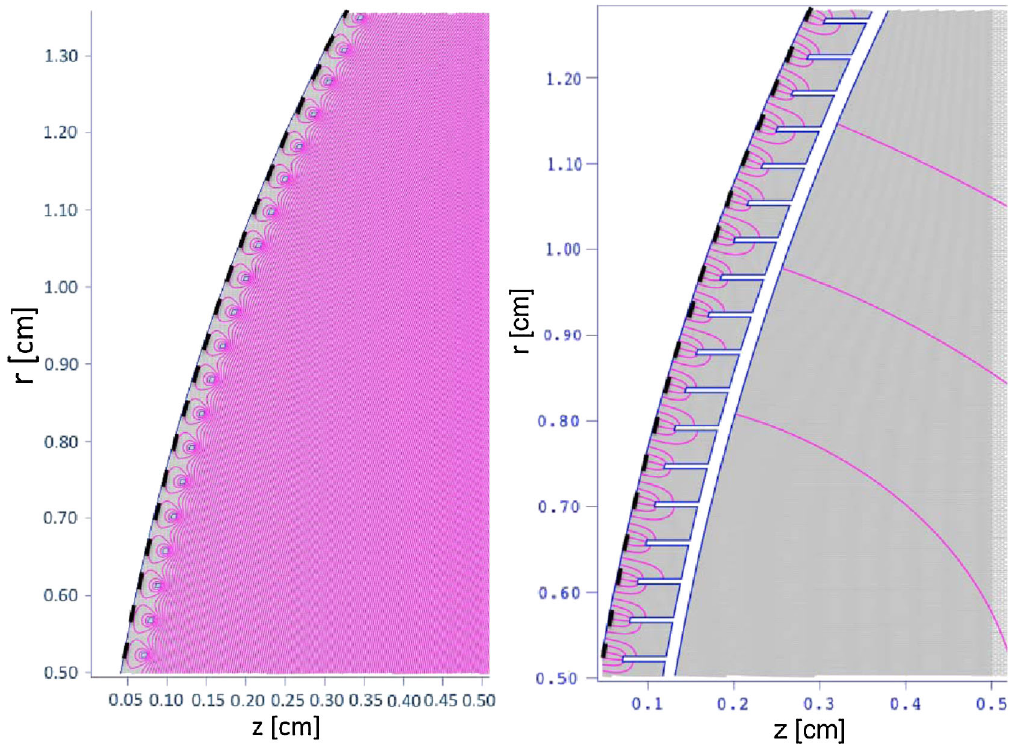
FIG. 15. Close-up of the grid region used in the PARMELA simulations of Fig. 17. Black lines illustrate the shadow grid used to prevent emission from the cathode beneath the grid wires. (Left) For the purpose of computing the static field, the grid is modeled as a series of concentric rings of radius r o ¼ 30 (cid:3) m . Curves denote contours of the electric potential due to the bias voltages on the anode and the grid. (Right) For the purpose of computing the rf field, the grid is modeled as a series of thin, concentric rings attached to a curved backing plate which confines the rf field to the grid-cathode region. The backing plate is transparent to electrons in the simulations. Curves denote field lines of the fundamental (700 MHz) rf field.